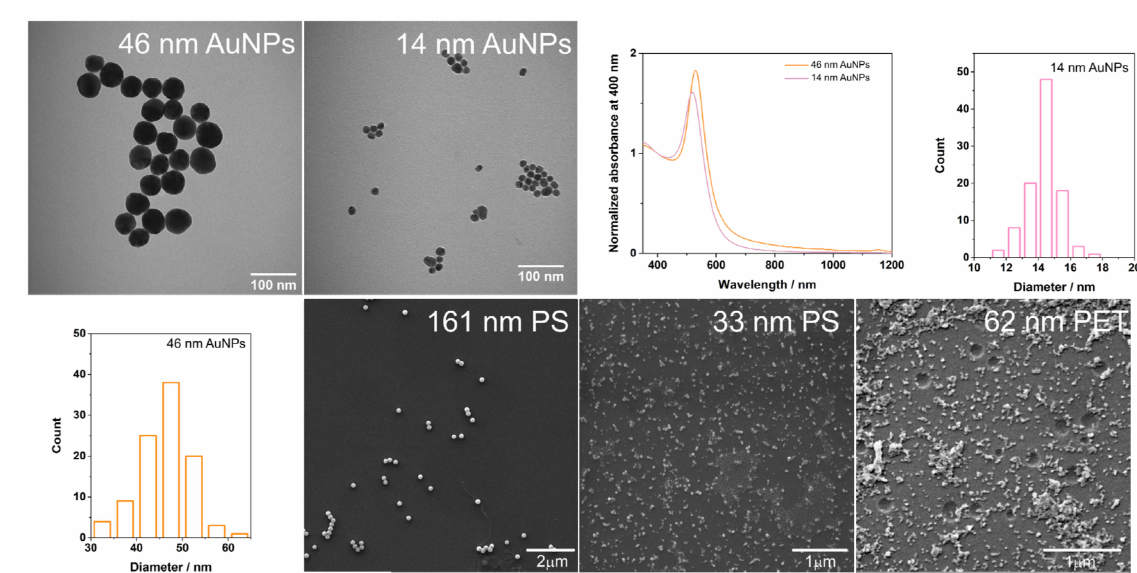
Figure A1. UV-vis extinction spectra for the stock AuNP dispersions are shown alongside representative TEM images for the 46 nm gold and the 14 nm gold stock particles as well as histograms of their sizing data. SEM images for the 161 nm PS, the 33 nm PS, and the PET are also shown.